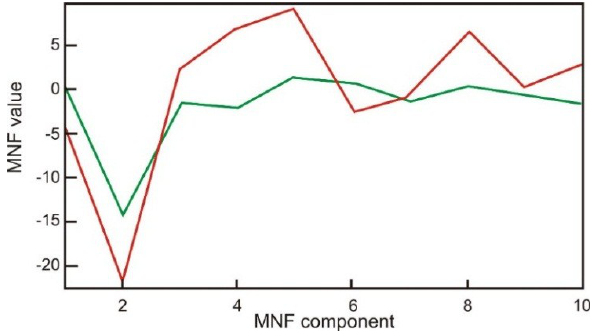
Figure 9. MNF signal-component curve for the water (green line) and pasture (red line) classes, which are characterized by different values and similar shapes.